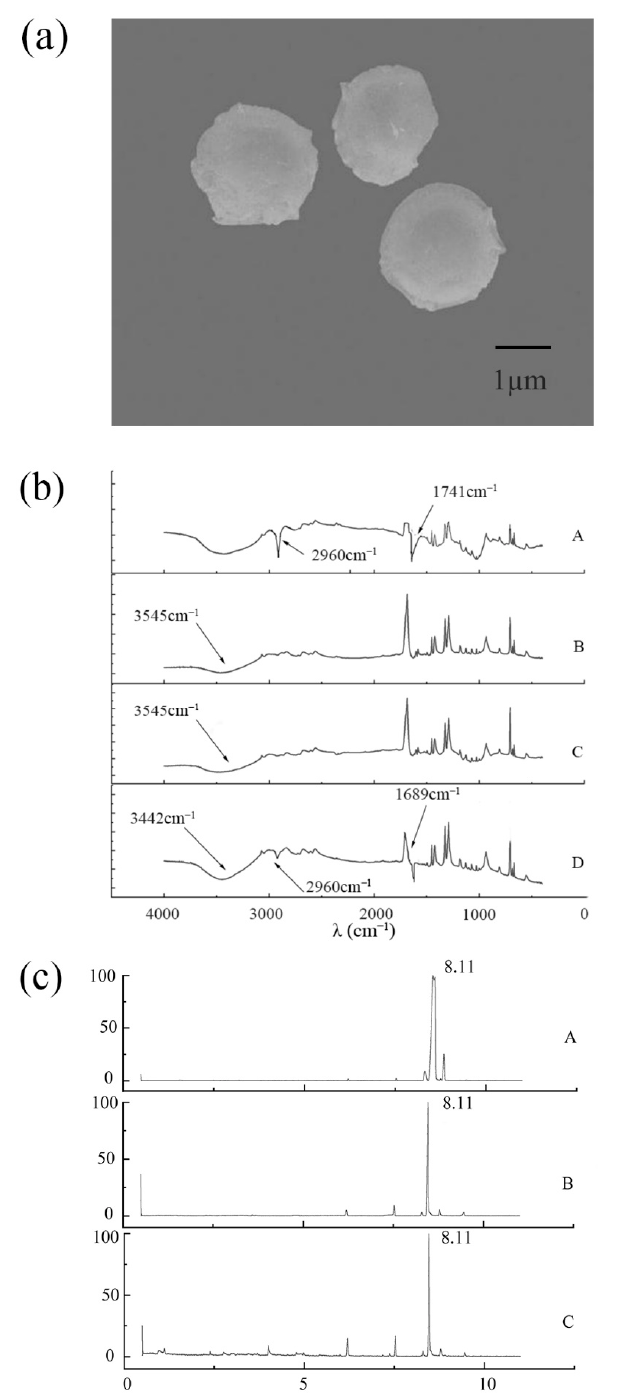
Figure 3. Characterization of methyl jasmonate microcapsules. Morphology of methyl jasmonate microcapsules ( a ); The FT-IR spectrography of pure methyl jasmonate ( b (A)), mixture of sodium alginate and chitosan ( b (B)), blank microcapsules ( b (C)), and MeJA microcapsules ( b (D)); Methyl jasmonate release from methyl jasmonate microcapsules detected by GC-MS at day 0 ( c (A)), day 15 ( c (B)) and day 30 ( c (C)).